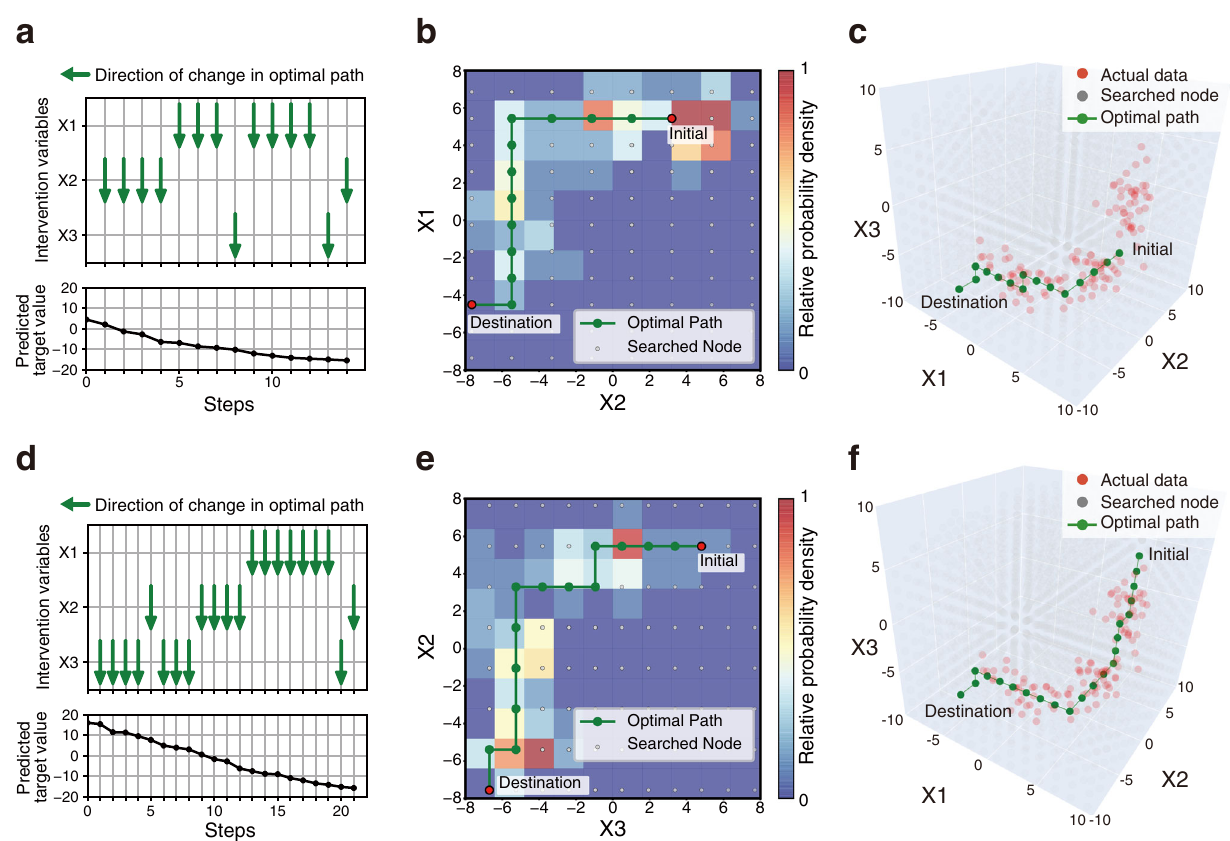
Fig. 4 Examples of actionable paths planned on synthetic dataset. The optimal paths for improving the response variable predicted by the ML model are represented for randomly selected two examples: instance A ( a – c ) and instance B ( d – f ). a , d The orders of changes in the explanatory variables in the optimal path and the accompanying changes in the predicted values. In the transition steps, the upward or downward arrow represents a unit increase or decrease in the explanatory variable, respectively. b , e Two-dimensional (2D) plots of the path. The 2D plots are shown regarding the selected two variables: X1 and X2 ( b ), and X2 and X3 ( e ). In the heatmaps, the probability density of the actual data, normalized by the panel with the maximum number of data, is expressed. c , f Three-dimensional (3D) plots of the path. Table 1 Subject characteristics during fi rst-time